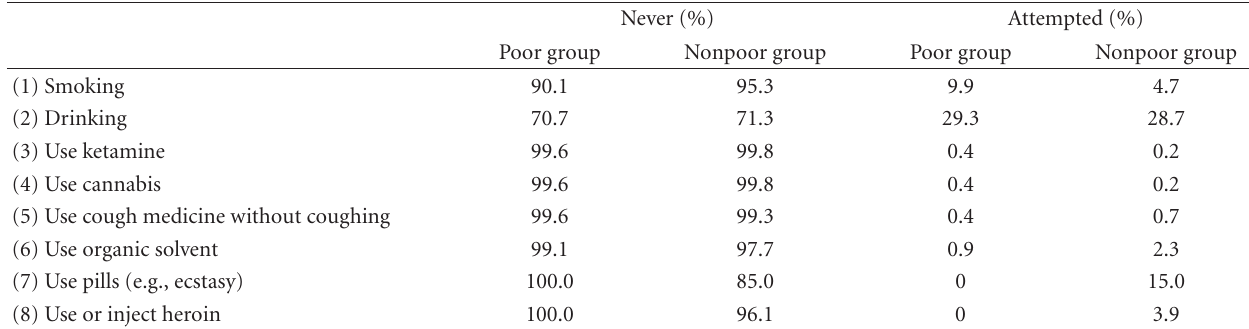
Table 2: Past year exposure to substances.